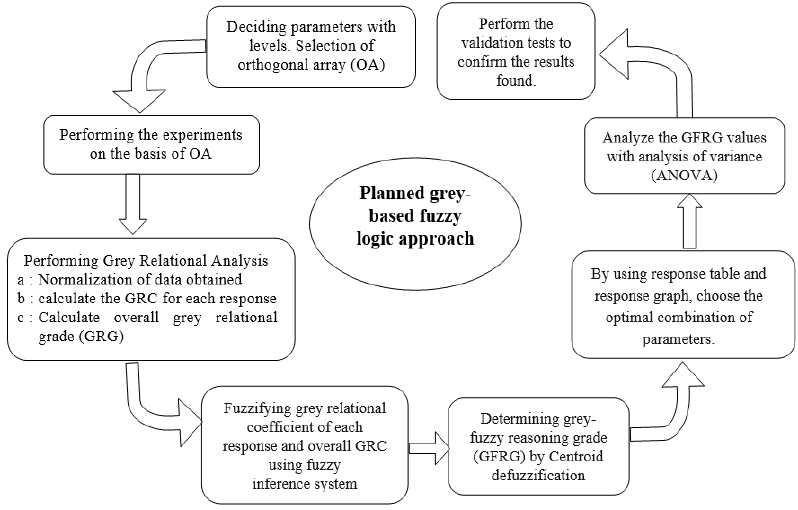
Figure 4. Steps used for the grey-fuzzy logic method.